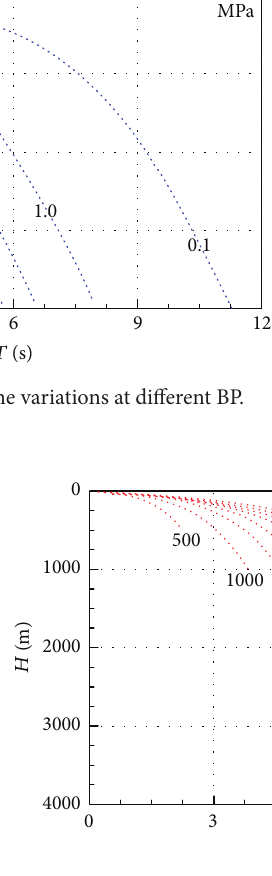
Figure 6: Wave velocity distribution at different well depth. Figure 7: Pressure response time variations at different well depth.